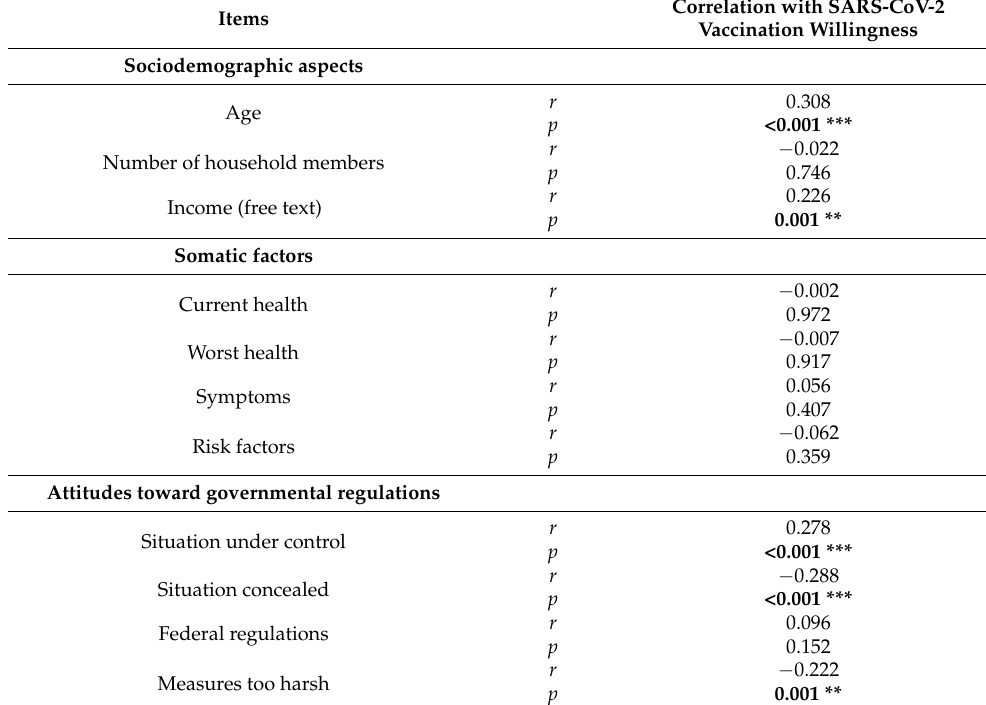
Table 4. Correlations of sociodemographic aspects, attitudes toward the government’s regulations, subjective informativeness, and susceptibility to conspiracy theories with SARS-CoV-2 vaccination willingness ( n =